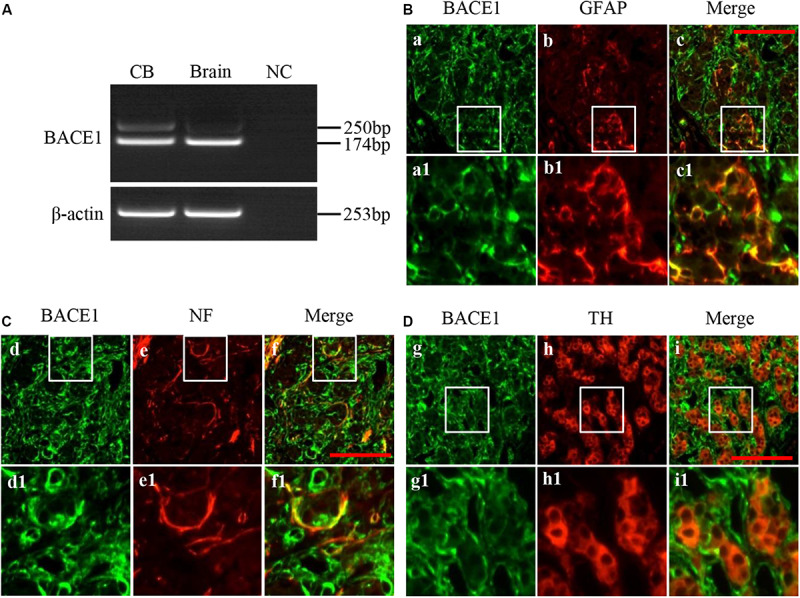
Expression and distribution of BACE1 in rat CB. (A) RT-PCR showed expression of BACE1 mRNA in rat CB (left lane). RNA extracted from rat brain cerebral cortex was used as positive control (Brain, middle lane). The DEPC-H2O, instead of RNA, was used in RT reaction to obtain a negative cDNA control. An equal volume of the negative cDNA control was used in the PCR as PCR negative control (NC). (B) Double immunofluorescent staining of BACE1 (green) and GFAP (red) in rat CB (a-c1). Glial fibrillary acidic protein (GFAP) was used to label CB type II cells. (C) Double immunofluorescent staining of BACE1 (green) and NF (red) in rat CB (d-f1). Neurofilament (NF) was used to label CB nerve fibers. (D) Double immunofluorescent staining of BACE1 (green) and TH (red) in rat CB (g-i1). Tyrosine hydroxylase (TH) was used to label CB type I cells. a1-i1 are higher magnifications images of rectangle areas in a-i, respectively. Scale bar = 50 μm.